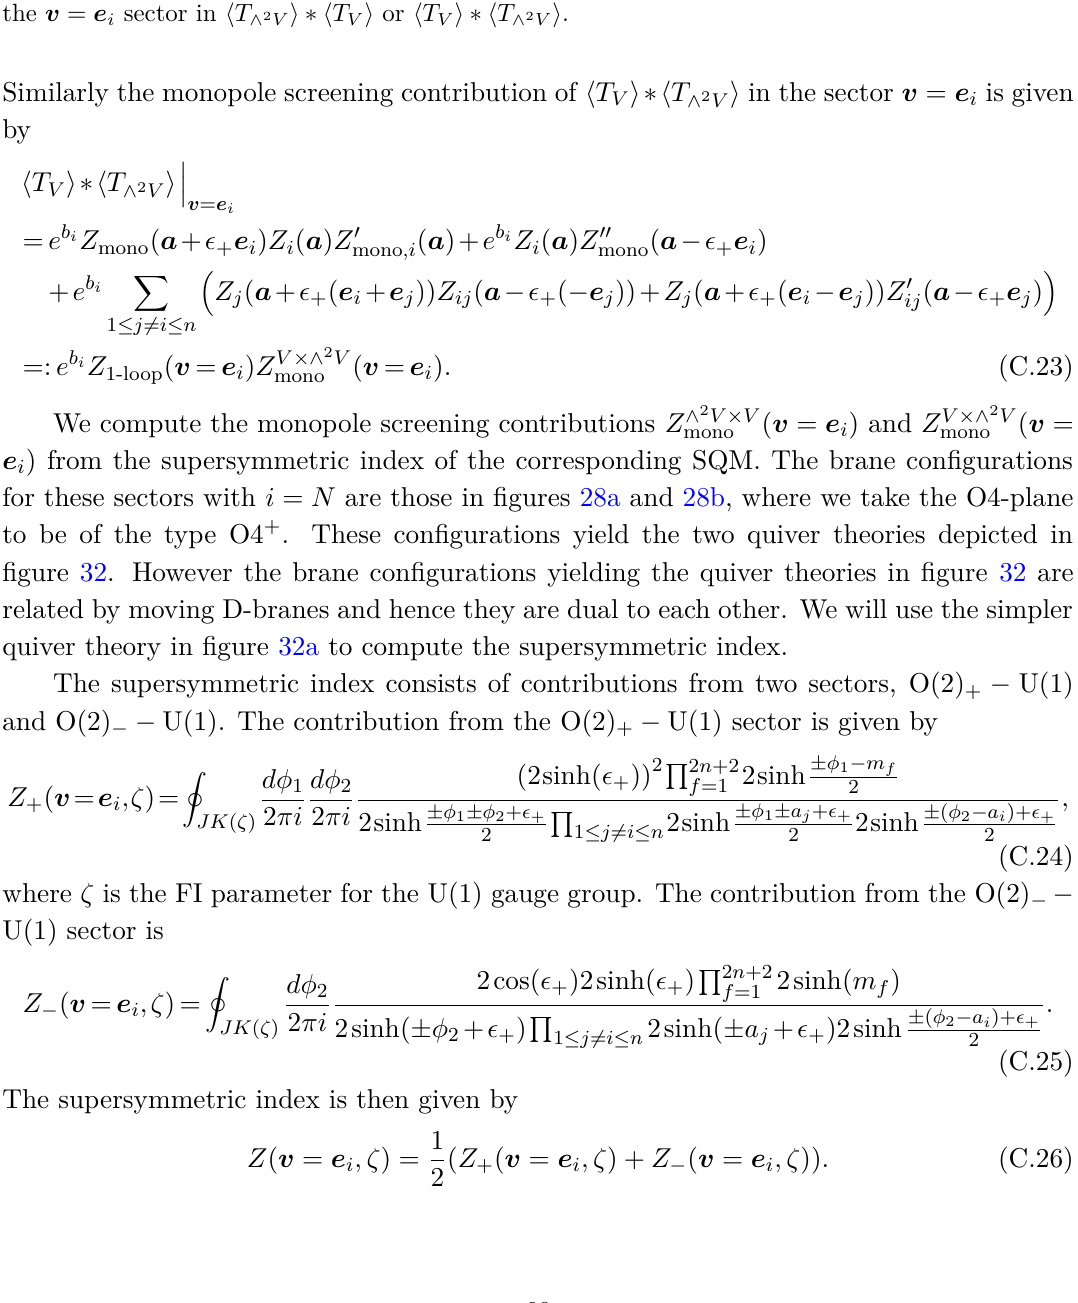
Figure 32. The two possible quiver diagrams describing the monopole screening contribution of the v = e i sector in h T i ∗ h T V i or h T V i ∗ h T i ∧ 2 V ∧ 2 V